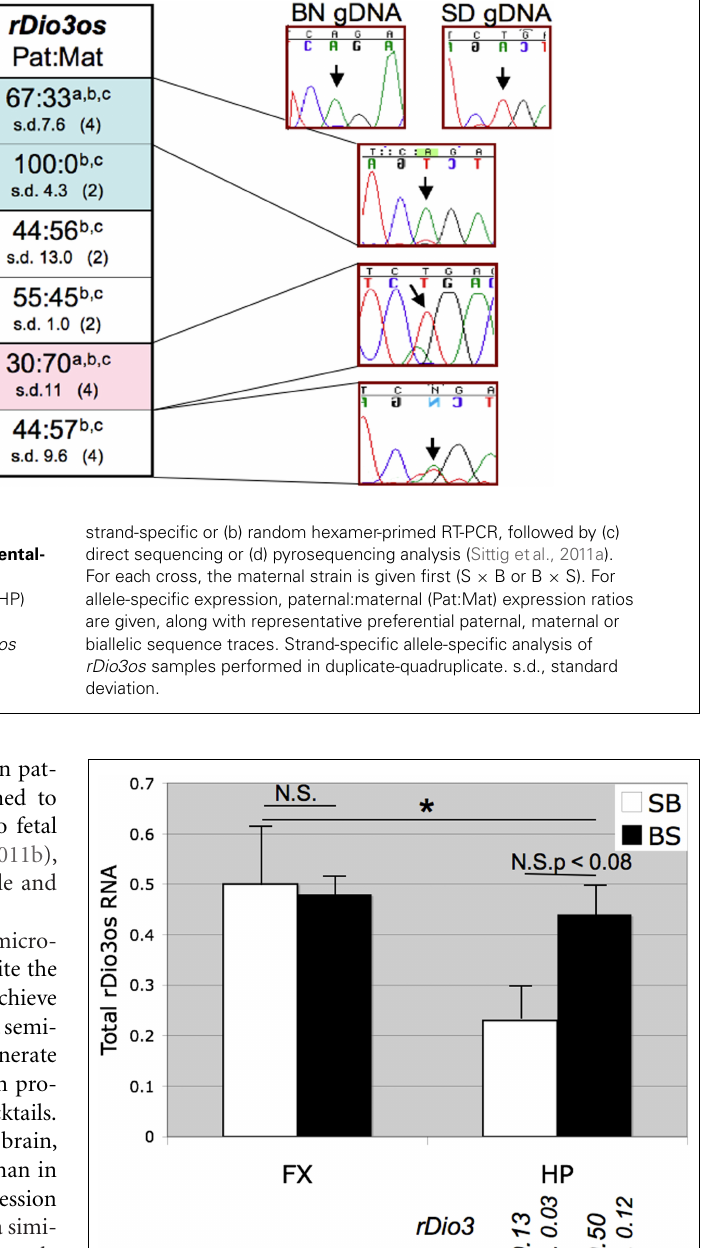
FIGURE 3 | Strain and brain region-specific effects on total rDio3os expression. As for rDio3 , semi-quantitative RT-PCR from adult male cortex demonstrates no significant difference between animals derived from a B × S cross vs. an S × B cross ( p < 0.84), whereas animals from the S × B cross exhibit significantly decreased total rDio3os expression in the hippocampus vs. cortex. S × B adult hippocampi also trend toward decreased rDio3os expression as compared with hippocampi from the B × S cross ( p < 0.08). For comparison, total rDio3 adult male hippocampal RNA expression is indicated below bars (from Sittig etal., 2011a; n = 7–8). Samples are normalized to rat beta-actin expression levels. n = 3–4; extreme outliers omitted from analysis. * p < 0.05; N.S., not significant; HP, hippocampus; FX, frontal cortex; s.d., standard